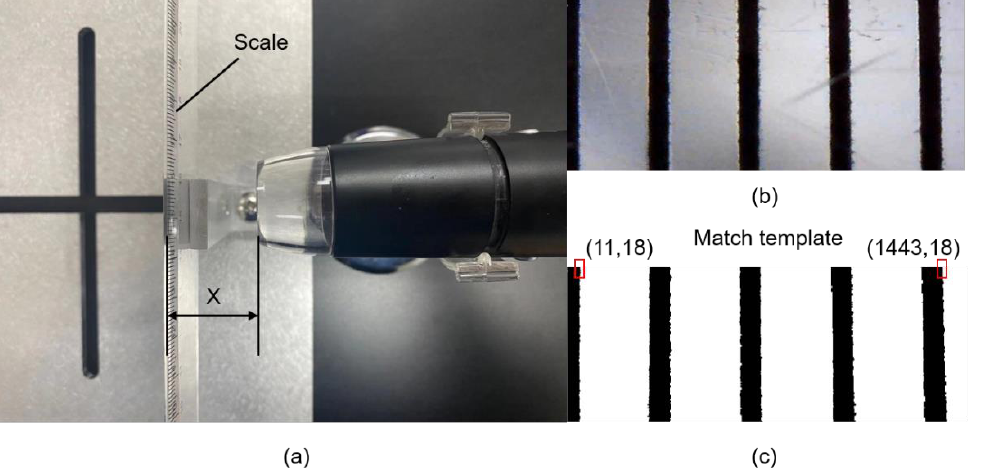
Figure 5. Experimental setup. ( a ) Experimental setup; ( b ) Schematic diagram of the experimental setup.